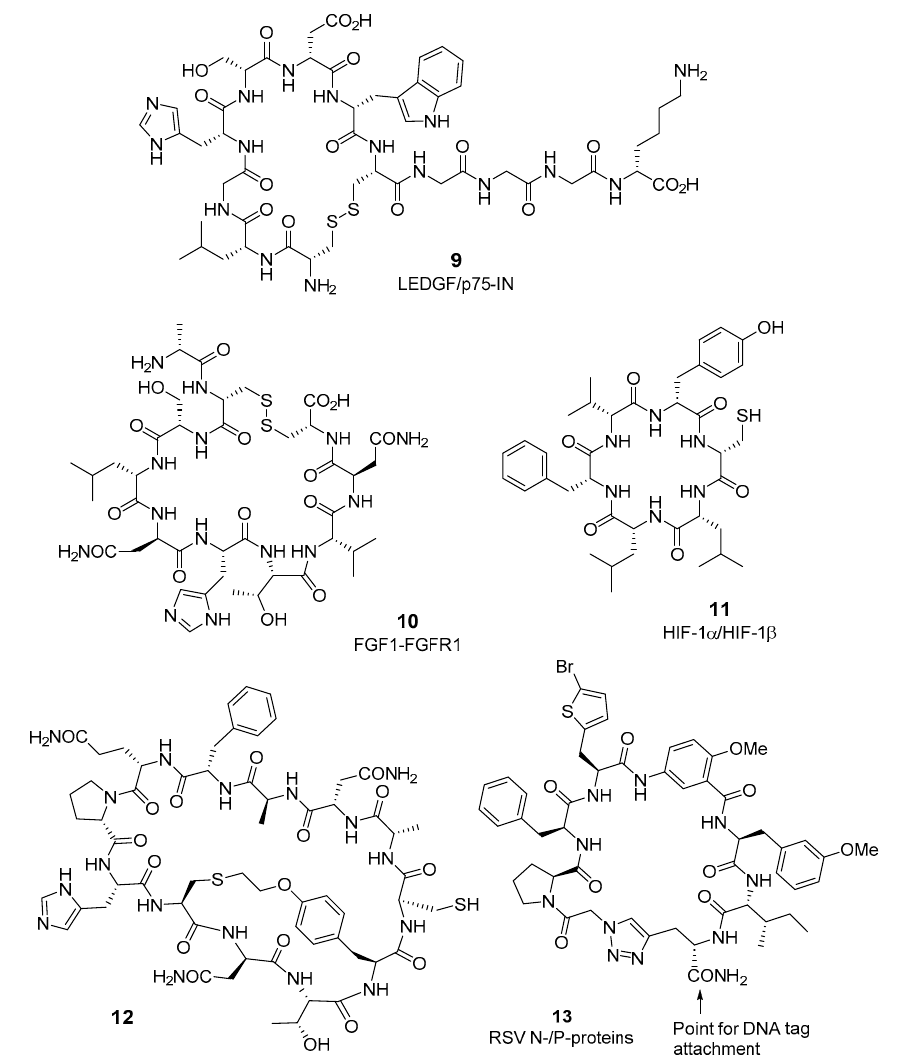
Figure 3. Cyclic/macrocyclic peptides discovered after application of biochemical